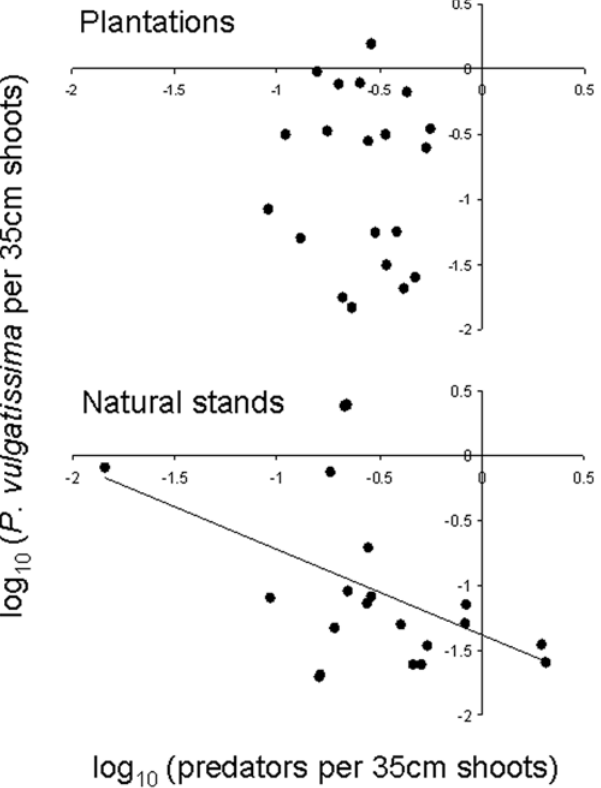
Figure 3. Correlations between P. vulgatissima and natural enemies . Each data point represent the mean density of the